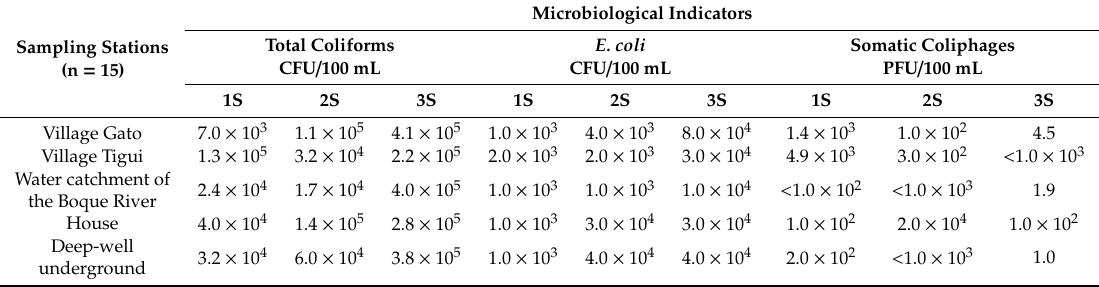
Table 4. Results of total coliforms, Escherichia coli , and somatic coliphages in waters of the Boque River and drinking